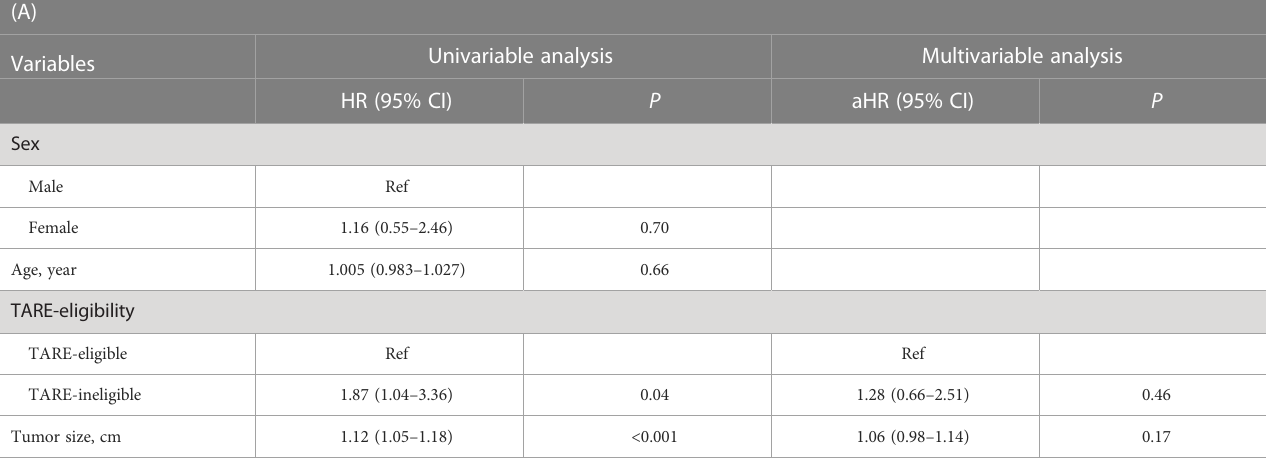
TABLE 4 Univariable and Multivariable Cox analyses for overall survival between TARE-eligible and TARE-ineligible groups before (A) and after (B) IPTW. (A) Variables Univariable analysis Multivariable